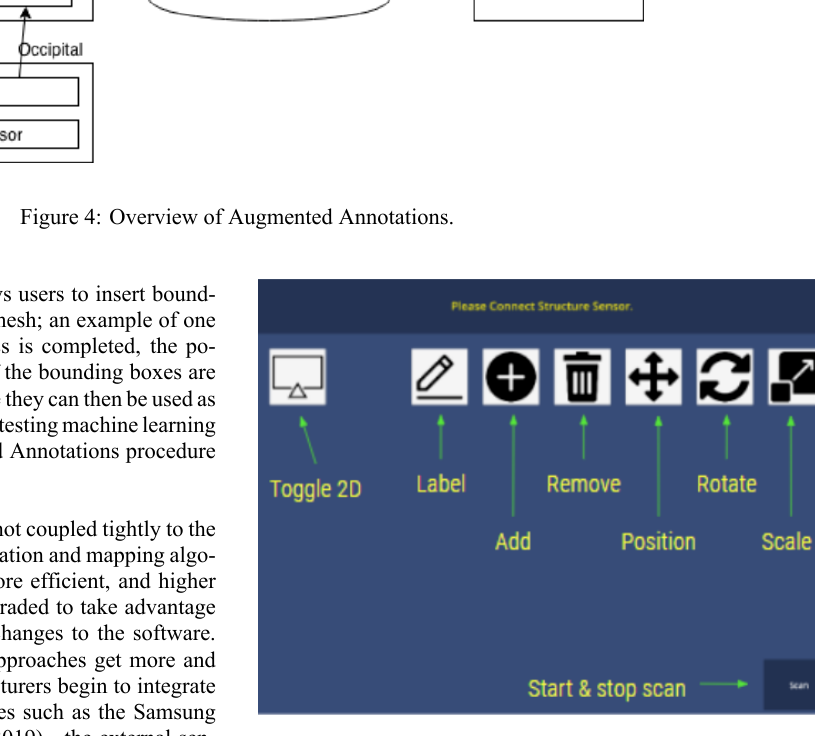
Figure 5: Augmented Annotation’s user interface. Gizmo buttons have been labeled with their corresponding functionality.